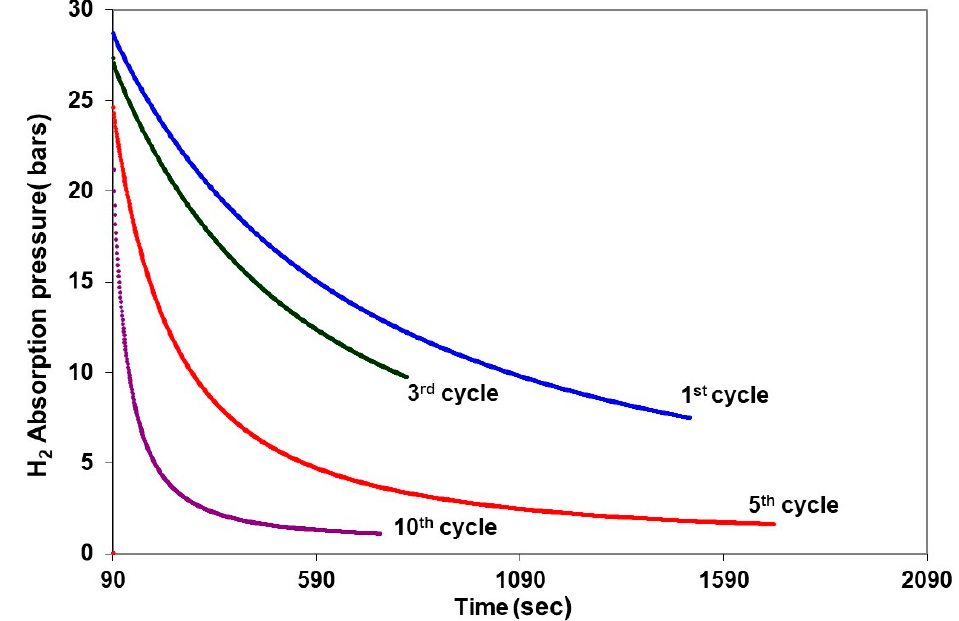
Figure 9. The hydrogenation kinetics of Ti-doped nanocrystalline Mg 2 FeH 6 ; the rate of hydrogen absorption increases with runs (mass of material: 1.5 g and desorption temperature: 250 °C) .